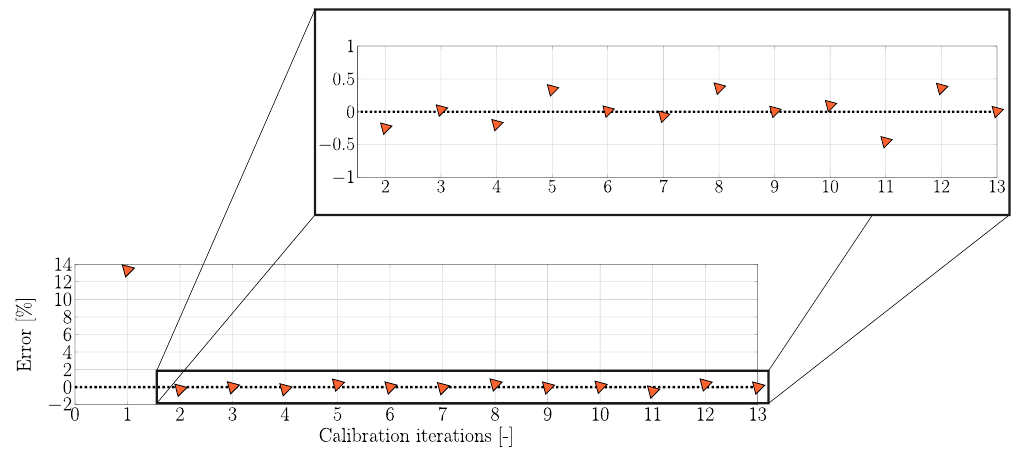
over 13 calibration iterations. H